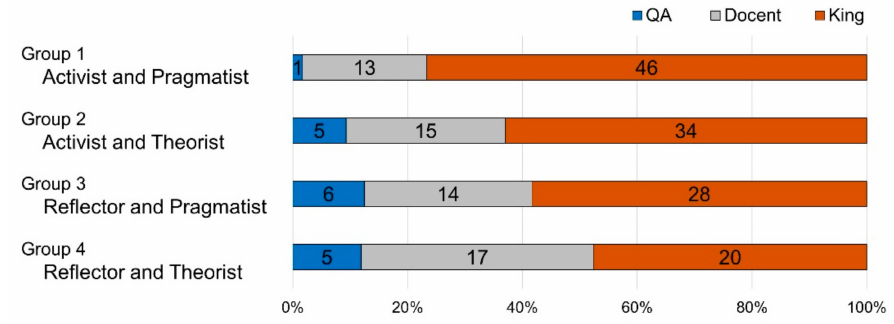
Figure 5. Best model preference by learning